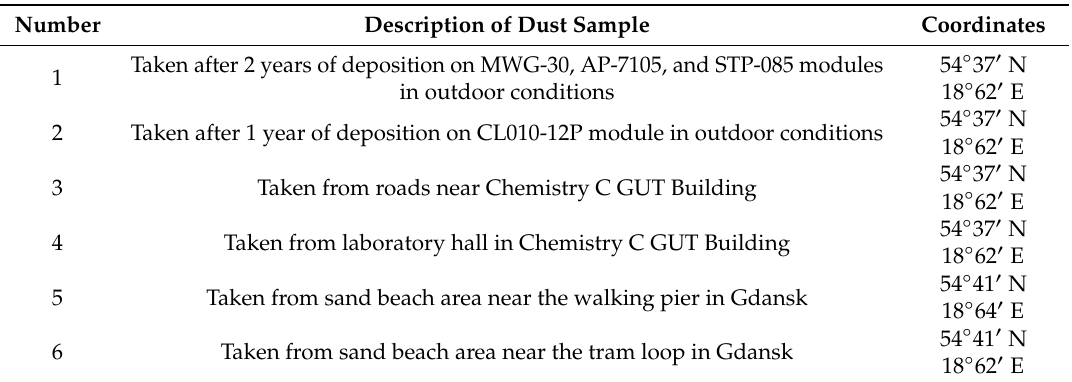
Table 3. Numbering of dust samples collected from photovoltaic modules, laboratory hall, and three various locations in Gdansk.